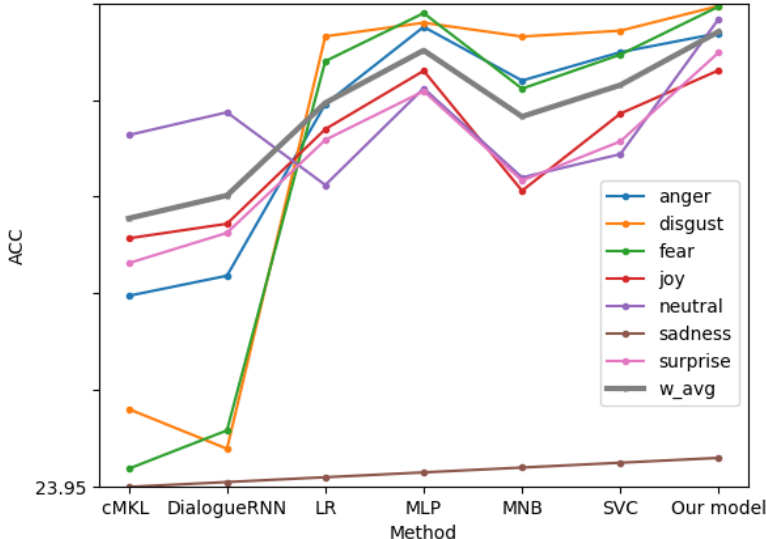
Figure 8. Fine-grained Emotion Accuracy Rate of Different Methods of MELD Data Set